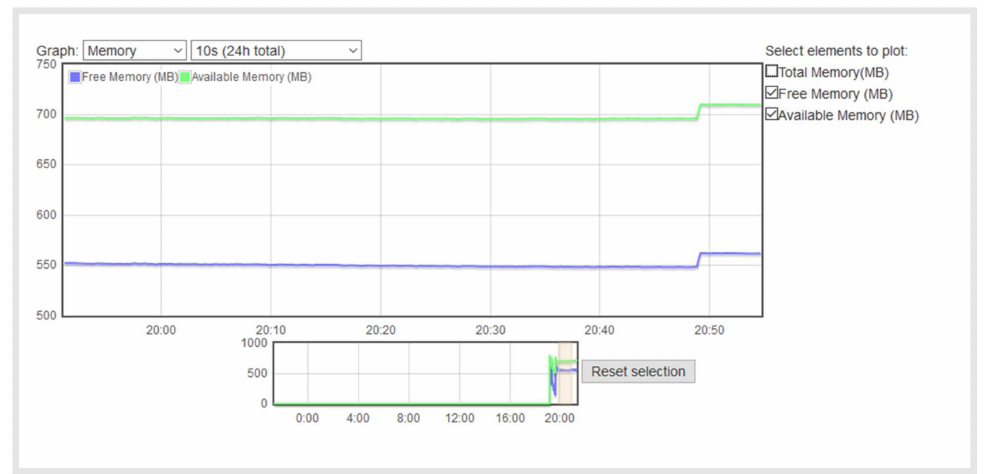
Figure 11. Raspberry Pi RAM memory with the Erlang implementation.